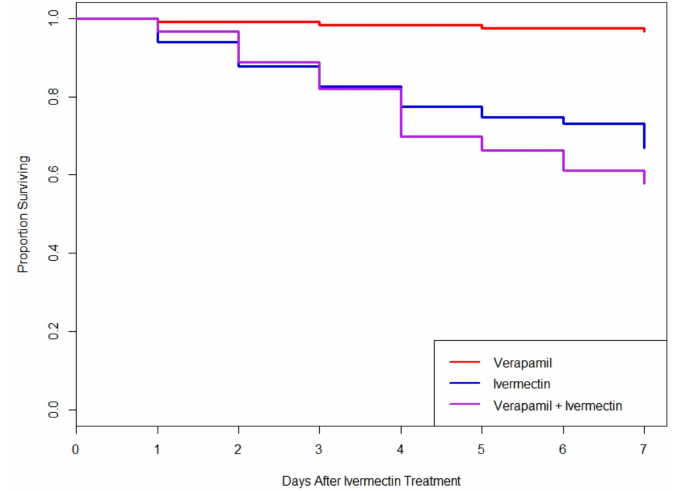
Figure 4. Proportion of adult L. decemlineata surviving in di ff erent verapamil and ivermectin feeding treatments. Nosignificantdi ff erenceswereobservedbetweentheivermectinandverapamil + ivermectin groups (log-rank test, χ 2 (1, 115) = 1.8, p =